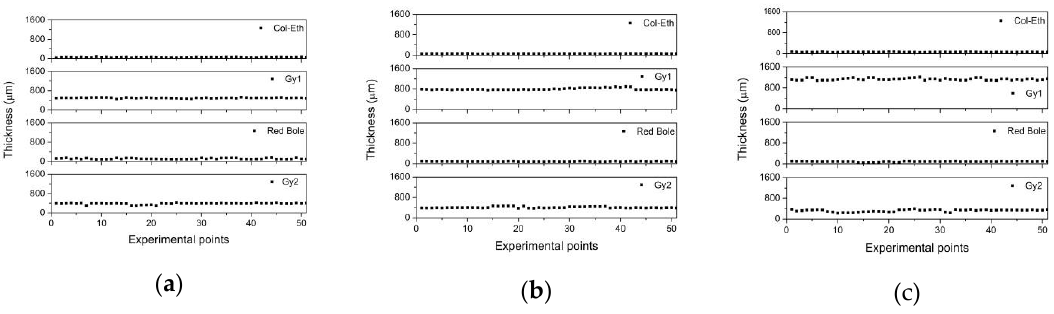
Figure 9. ( a ) Thicknesses of 51 points in areas A2; ( b ) area B2; ( c ) area C2. In the three cases the stratigraphy comprises varnish (Col-Eth), outer gypsum (Gy1), red bole (Red Bole) and inner gypsum (Gy2) layers.